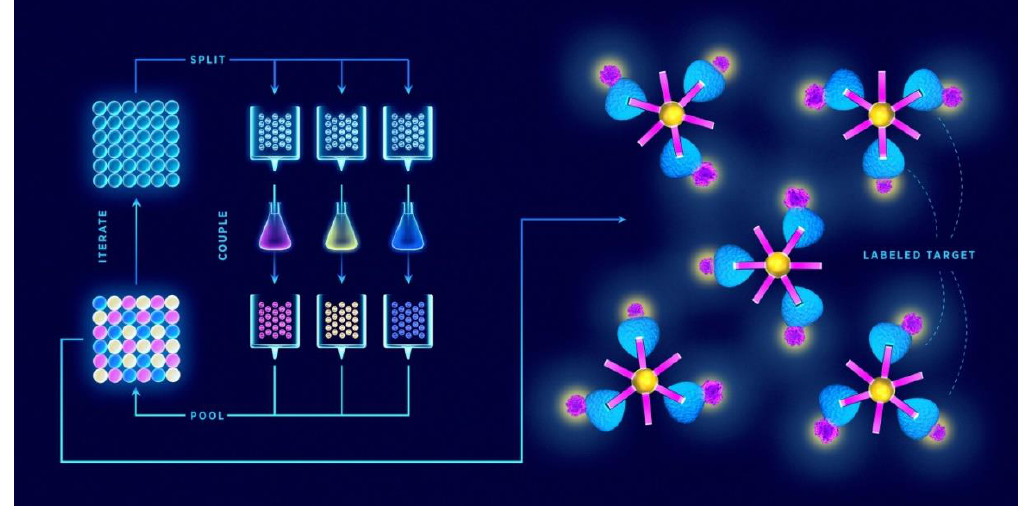
Figure 1. Synthesis of combinatorial peptide libraries by the “split-and-mix” method. Carrier beads are split into aliquots (only 3 are shown for clarity) for coupling individual amino acid residues, pooled, and the process is iterated until the desired length of peptides is achieved. Library diversity increases exponentially with each coupling step. At the end, each bead carries a single peptide sequence; hence, the name “one-bead-one-compound” combinatorial library. Libraries are typically screened by incubating the beads with a fluorophore-labeled target and subsequent fluorescence-activated sorting.